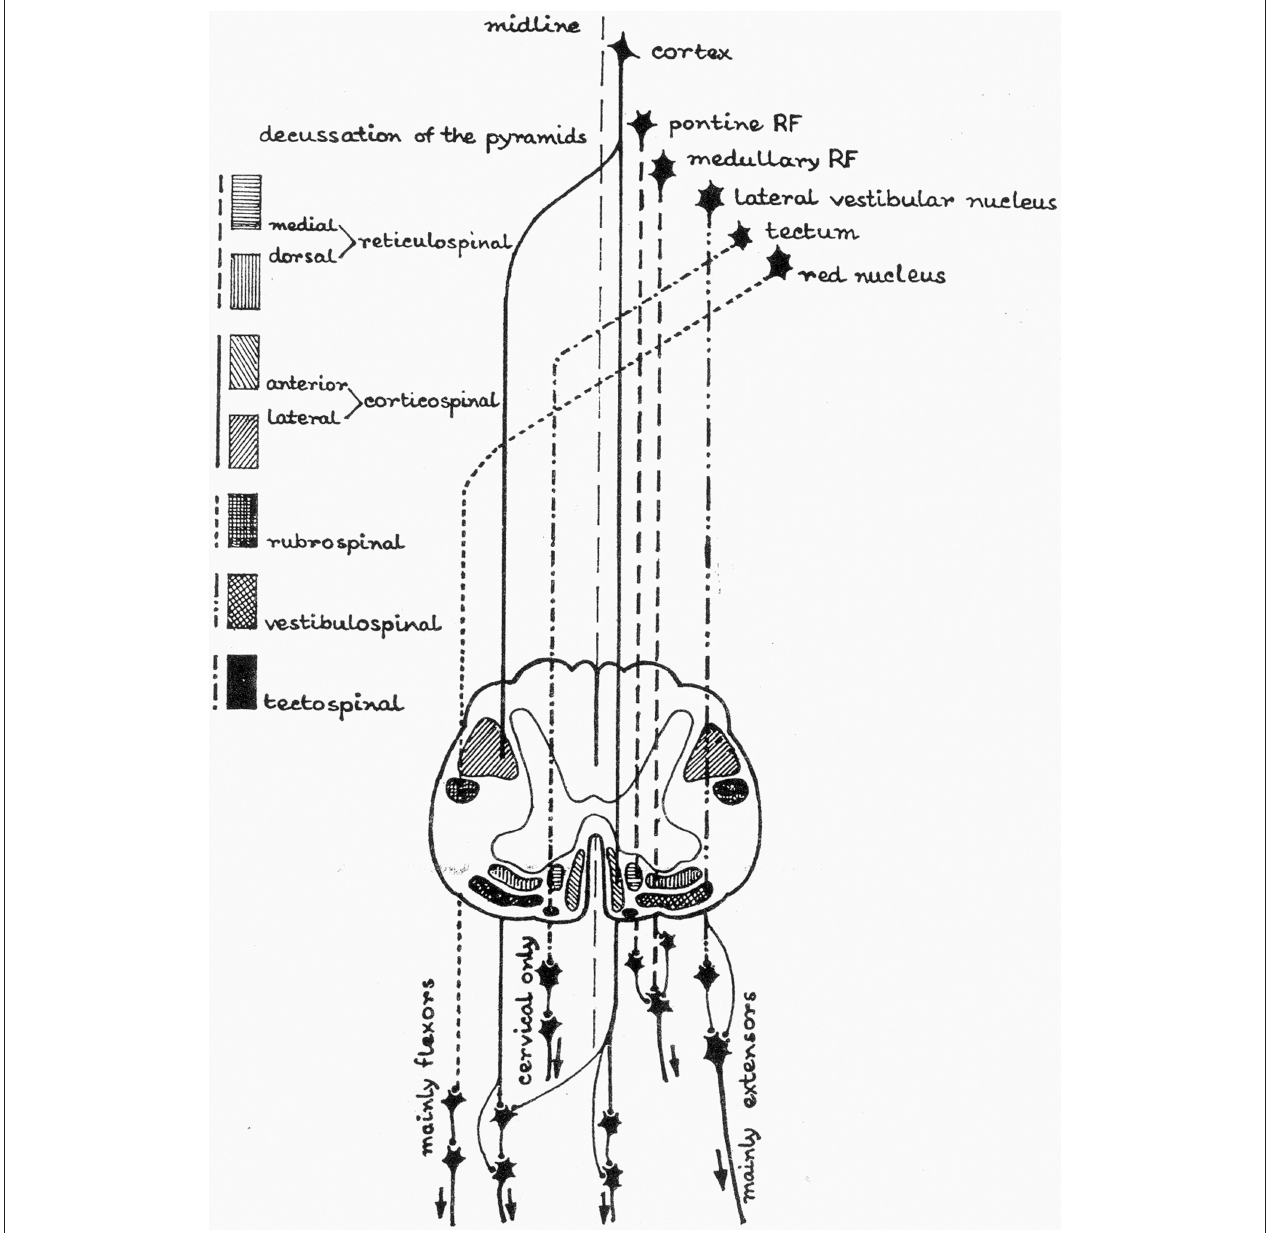
Figure 3 | Supraspinal descending pathways in spinal cord (rF, reticular